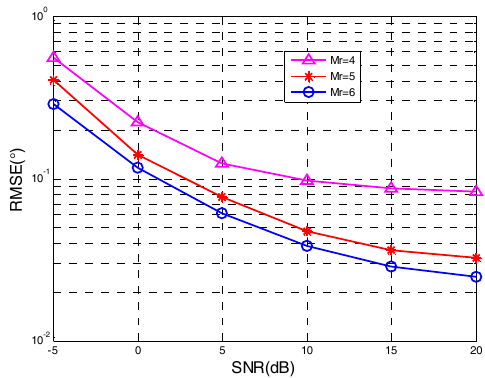
Figure 6. Angle tracking with different values of Mt .